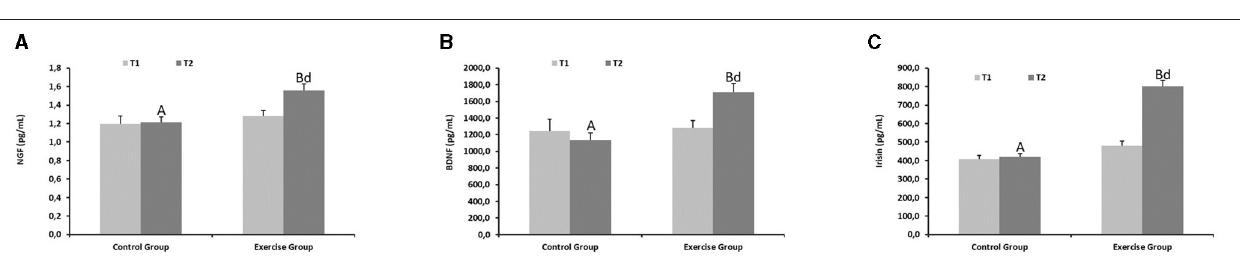
FIGURE 3 | Cognitive function parameters from the control and exercise groups. Mean values among groups with different letters differ ( P < 0.05) ( a,b for T1 and A,B for T2 by Student’s t test between different groups; d for T1 vs. T2 in the same group by Tukey’s test). NGF, Nerve growth factor; BDNF, Brain-derived neurotrophic factor.